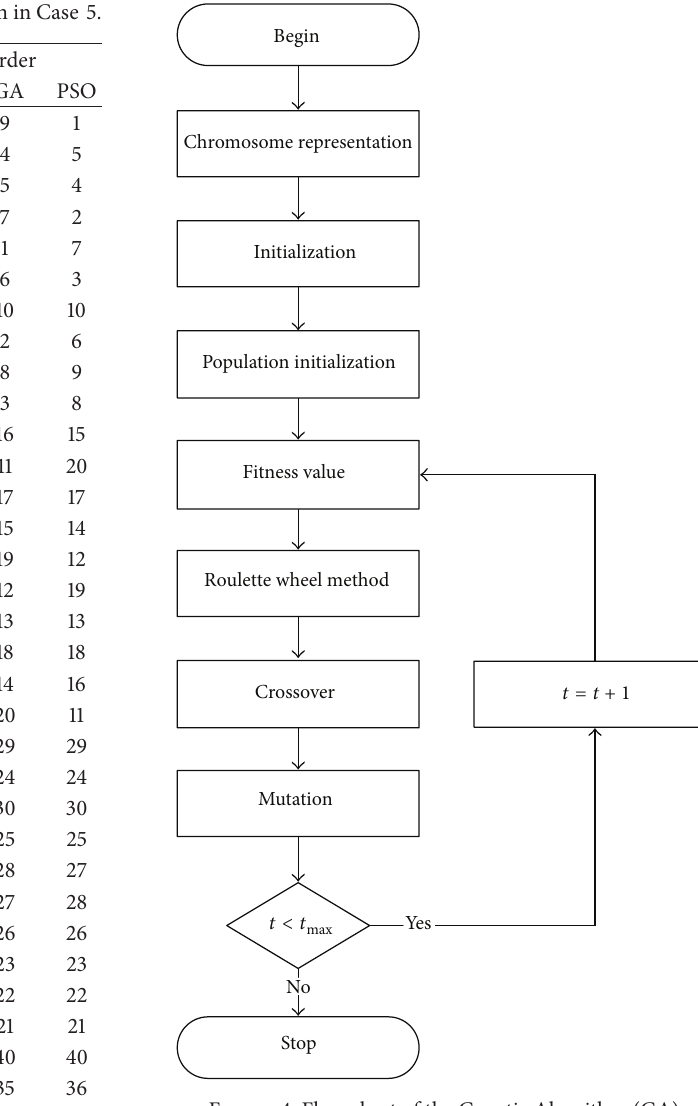
Figure 4: Flow chart of the Genetic Algorithm (GA).